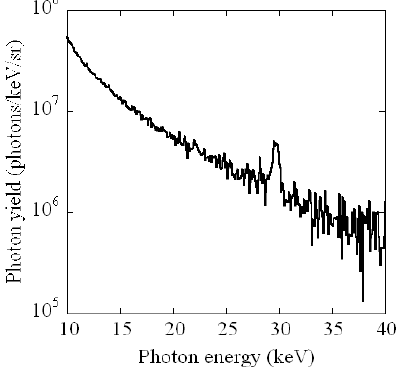
Figure 17. Energy spectrum of the X-ray radiation generated by laser-cluster interaction.